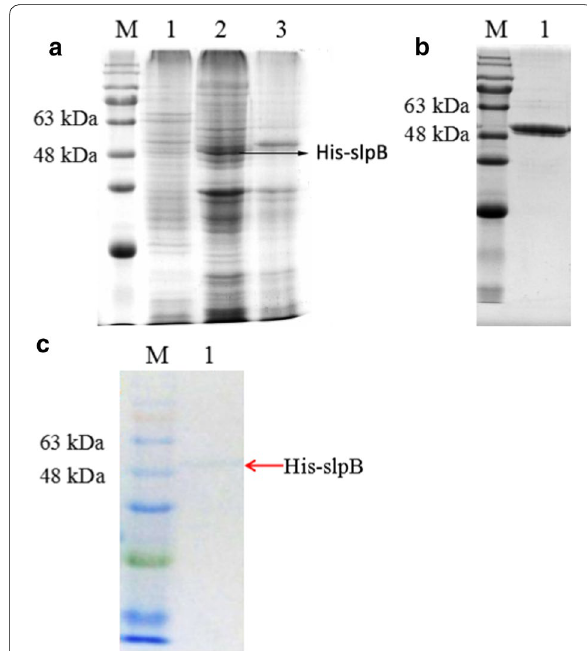
Fig. 2 Expression and purification of the fusion His-slpB protein. a Expression of His-slpB fusion protein. (1) E. coli DH (DE3) without transformation as a negative control; (2) Induced E. coli DH (DE3) expression of His-slpB fusion protein; (3) Un-induced E. coli DH (DE3) expression of His-slpB fusion protein; b SDS-PAGE of purified His-slpB. c Western blot of purified protein